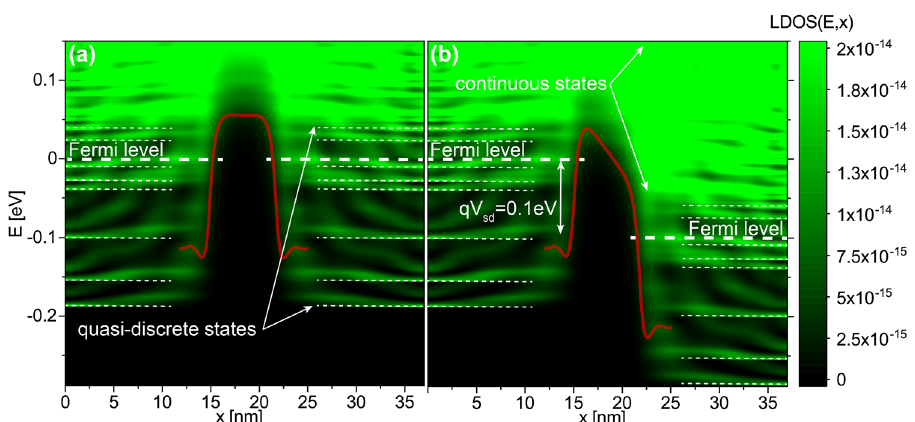
Figure 8. Local density of states for δ -layer tunnel junctions. The LDOS ( E , x ) for a tunnel junction of 7 nm is shown in ( a ) and ( b ) when a voltage of 1 mV and 100 mV is applied to the right side of the L gap = tunnel junction, respectively. Subfigure a indicates that the quantized states around the Fermi level might affect the conductivity for low applied biases due to a possible mismatch between the left and right quasi-discrete states, i.e., when the corresponding quasi-discrete peaks from the left and right sides are not aligned. Subfigure ( b ) shows that for high applied voltages the mismatch becomes impossible due to the availability of unoccupied continuum states on the right side for tunneling from the left side. In ( a ) and ( b ), the corresponding effective 1D potentials are also shown, calculated by integrating over the (y,z)-plane the actual charge self-consistent 3D potentials weighted with the electron density. N D 1 t =